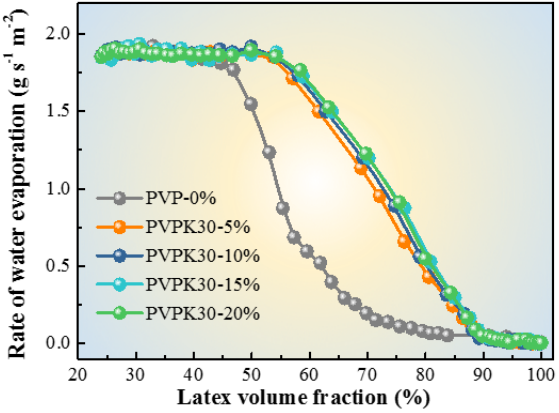
Figure 2. The influence curve of PVPK30 dosage on the drying rate of latex.